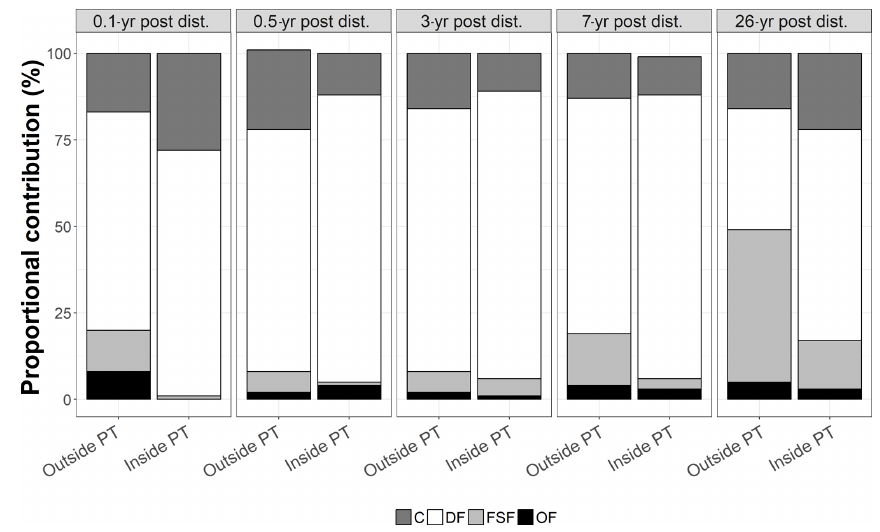
Figure 4. Proportional contribution (in %) of the feeding types C = carnivores, DF = deposit feeders, FSF = filter and suspension feeders, and OF = omnivores to the total carbon stocks outside and inside plough tracks in the DISCOL experimental area (Peru Basin, SE Pacific) 0.1- year post-disturbance (PD 0 . 1 ), for 0.5-year post-disturbance (PD 0 . 5 ), for 3-year post-disturbance (PD 3 ), for 7-year post-disturbance (PD 7 ), and for 26-year post-disturbance events (PD 26